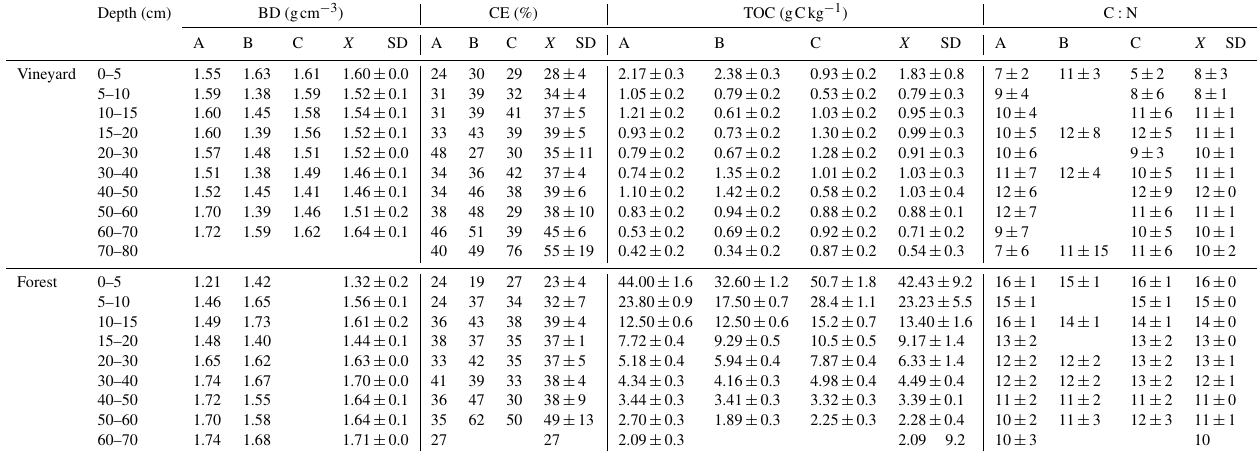
Table D1. Table of bulk density (gcm − 3 ), coarse elements (%), TOC (gCkg − 1 ), C : N ratio as a function of plant cover and depth. A, B, and C are the pit profiles, BD is the bulk density, CE is the coarse element, ± is the analytical error, X is the mean of the three A, B, and C profiles, and SD is the standard deviation.